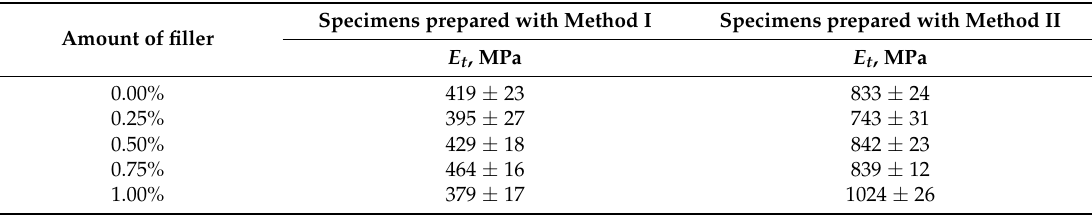
Table 4. Tangent modulus E t of the modified adhesive specimens prepared with Methods I and II (mean values and standard